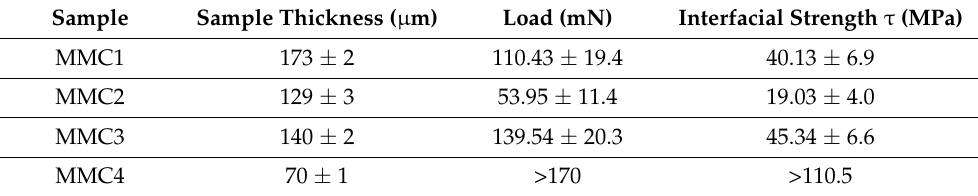
Figure 2. Images of a composite plate stitched to scaffold (light grey) before tests. Table 2. Results of push-out tests for samples fabricated by high pressure die casting and gas pressure infiltration